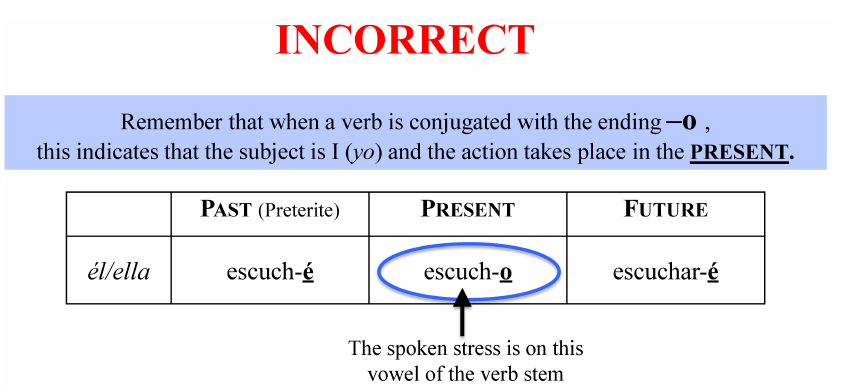
Figure 3. Example of Metalinguistic Feedback Following a Tense Question during Aural Training Practice.